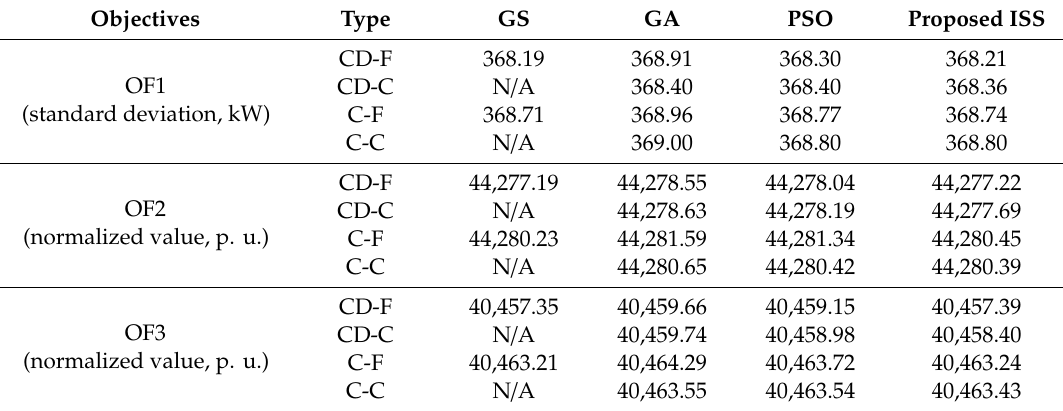
Table 4. Mean values of the methods for single EV